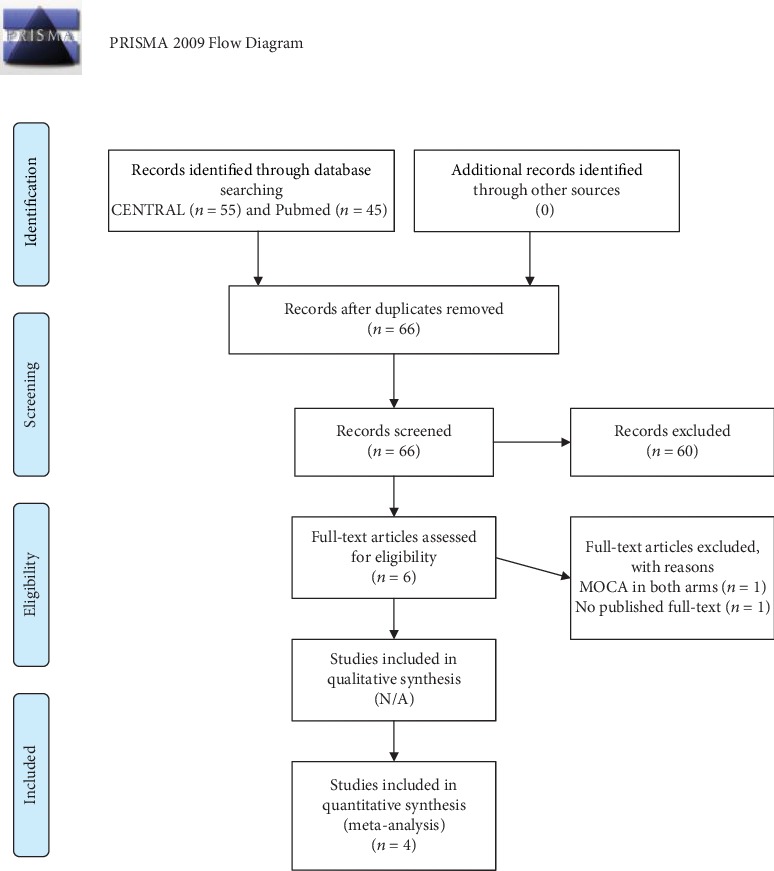
PRISMA flow diagram.